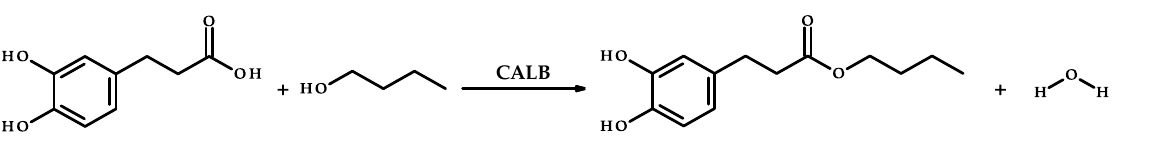
Figure 2. Synthesis of dihydrocaffeic acid butyl ester catalyzed by lipase B from C. antarctica